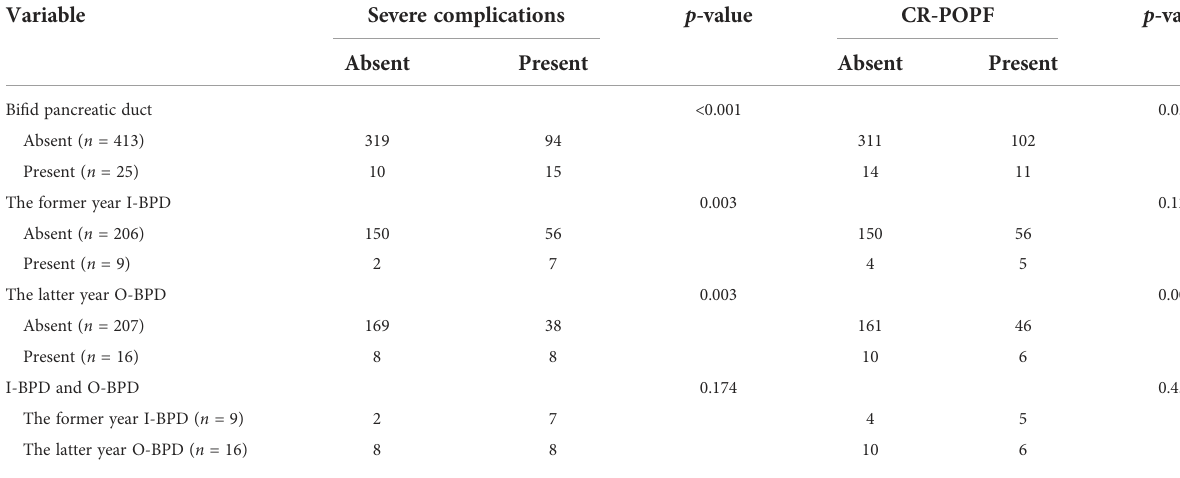
TABLE 2 Bi fi d pancreatic duct and postoperative complications.